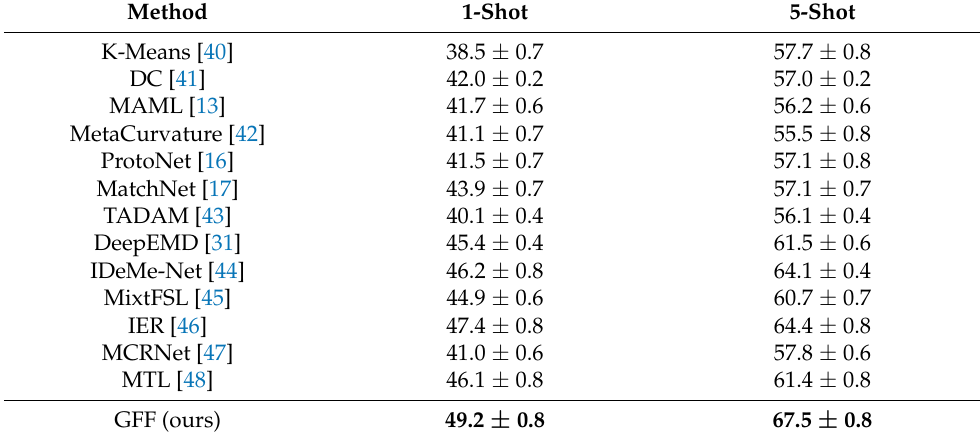
Table 4. Classification accuracies (%) with different methods in the 5-way K-shot cases on CIFAR- 100.